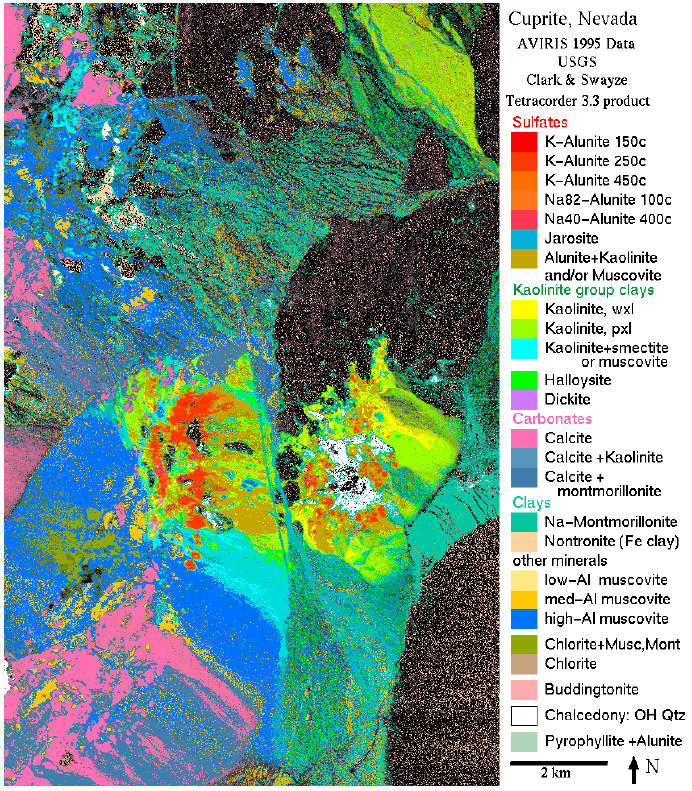
Figure 6. The USGS ground-truth map of Cuprite.